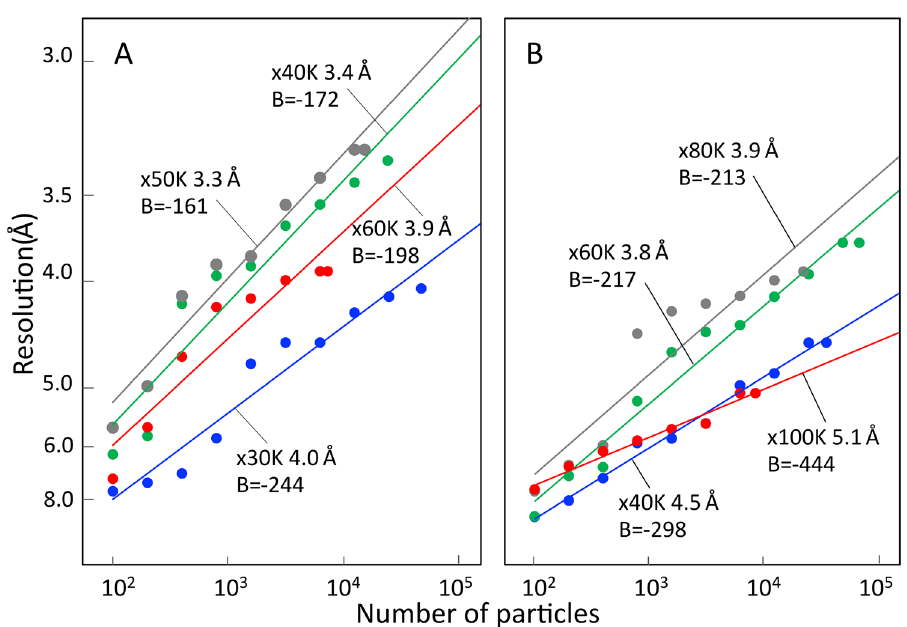
Figure 2. B-factor plots of all reconstructions. The points were calculated by bfactor_plot.py in RELION 3.0 at different magnifications. B-factor values are estimated from the fitted slopes. ( A ) Setting A and ( B ) Setting B. Magnifications are labelled